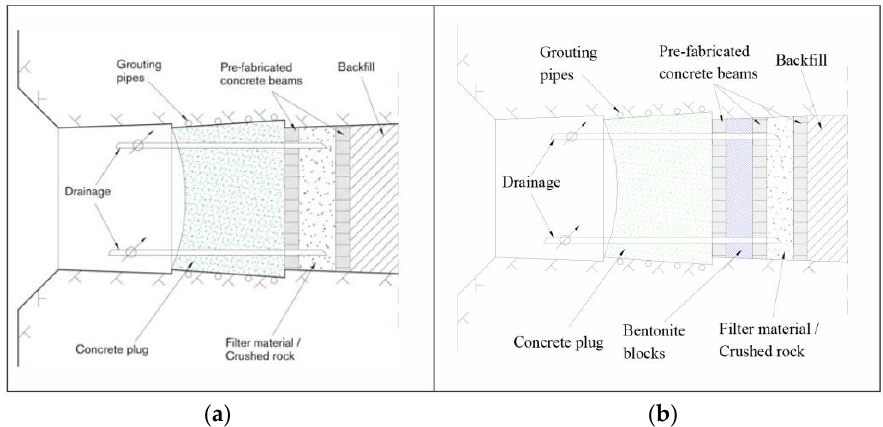
Figure 11. Design of conical concrete plug without ( a ) and with an intermediate bentonite layer ( b ) between the filling of the tunnel and the plug itself [49].